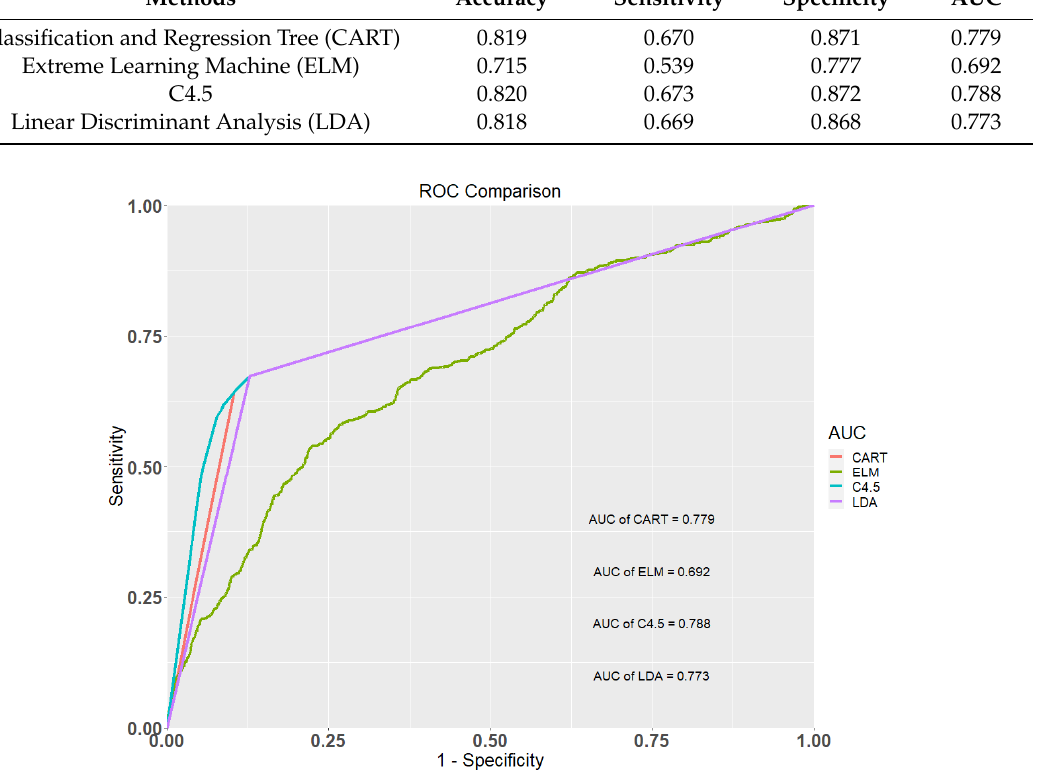
Figure 1. Receiver operating characteristic (ROC) curves of the four methods.